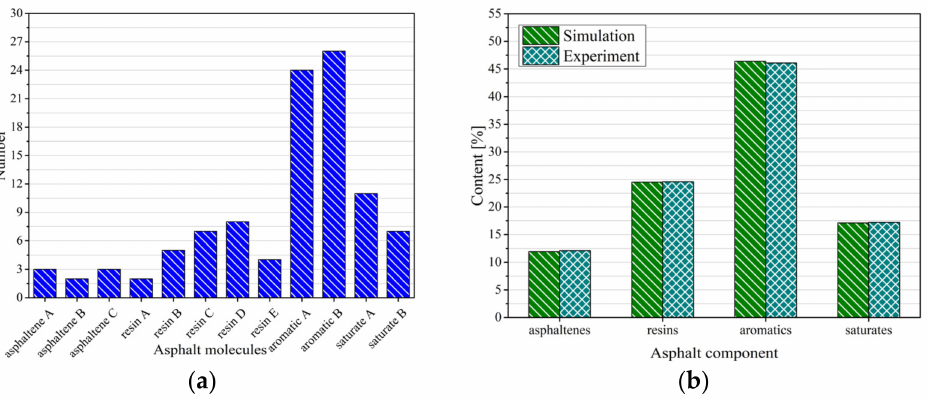
Figure 4. Number of molecules of the asphalt model ( a ) and the ratio of the model to the experiment in terms of four components ( b